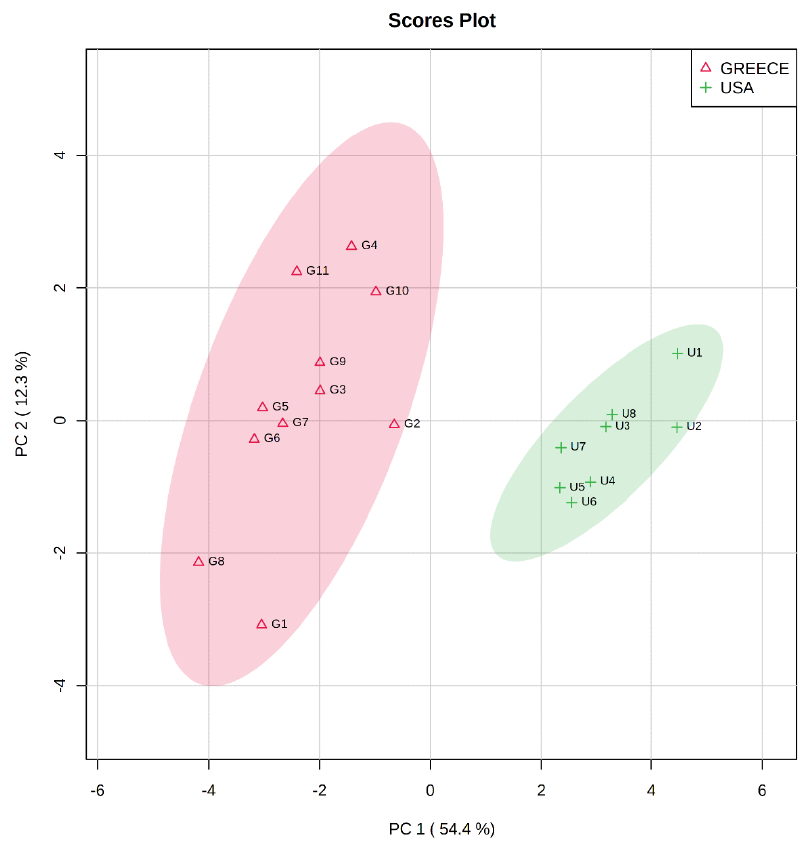
Figure 1. PCA Score plot showing the pairwise correlation between PCs in the clustering between Greek and American almonds.